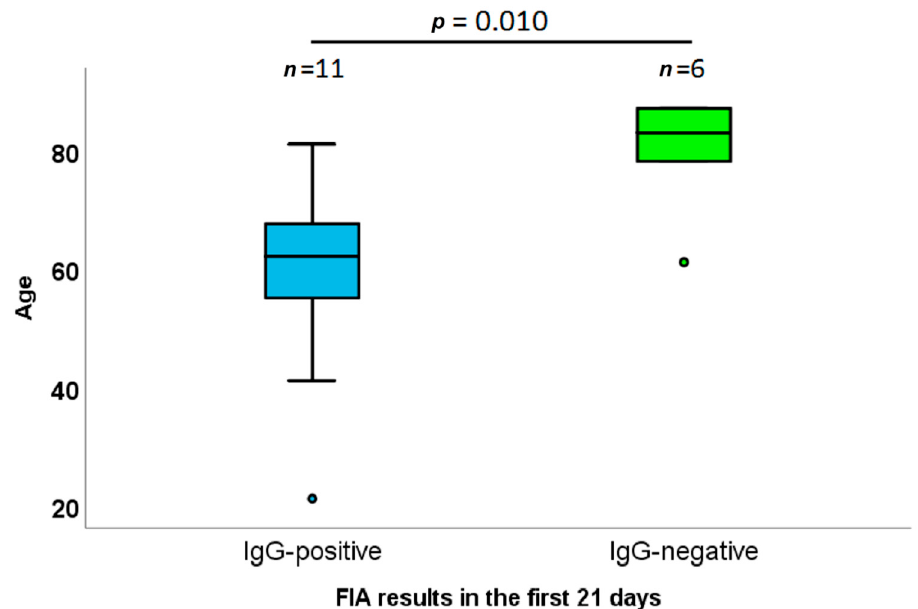
Figure 3. Age distribution among IgG-positive and IgG-negative patients 21 days the first molecu- lar diagnosis of SARS-CoV-2.